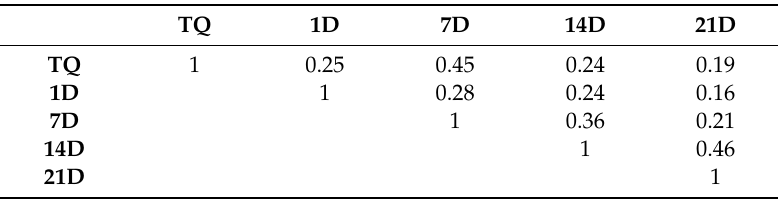
Table 4. Jaccard’s similarity